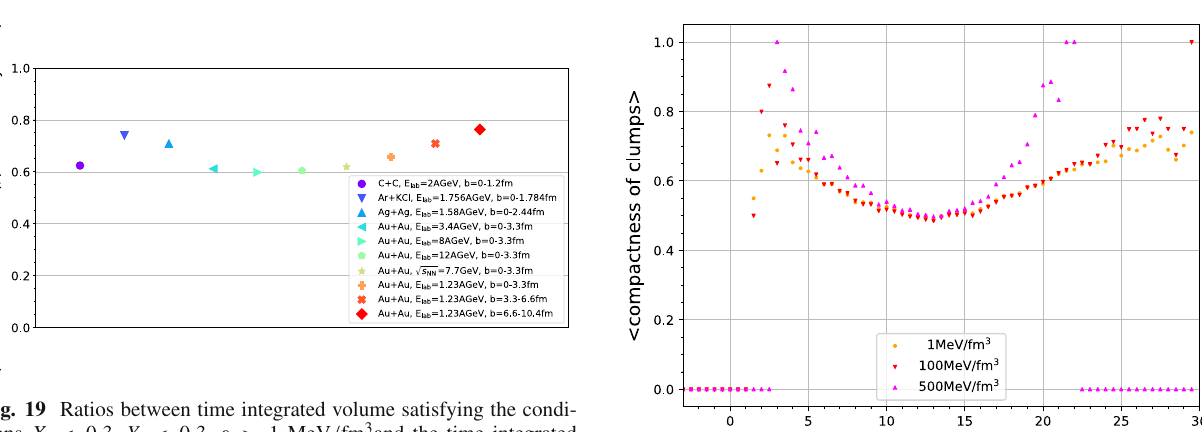
Fig. 19 Ratios between time integrated volume satisfying the condi- tions X < 0 . 3, Y < 0 . 3, ε > 1 MeV / fm 3 and the time integrated volume of the whole system